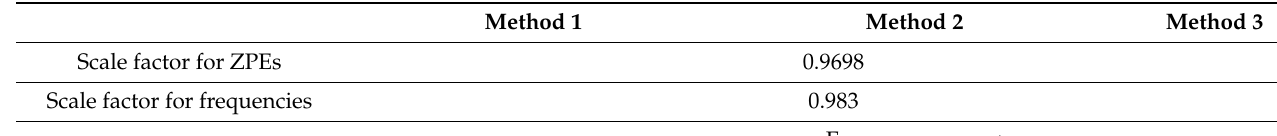
Table 2. Parameters and equations used for energy calculation in this